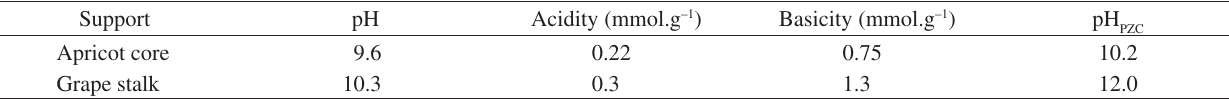
Table 2. Physicochemical characteristics of the activated carbon supports.